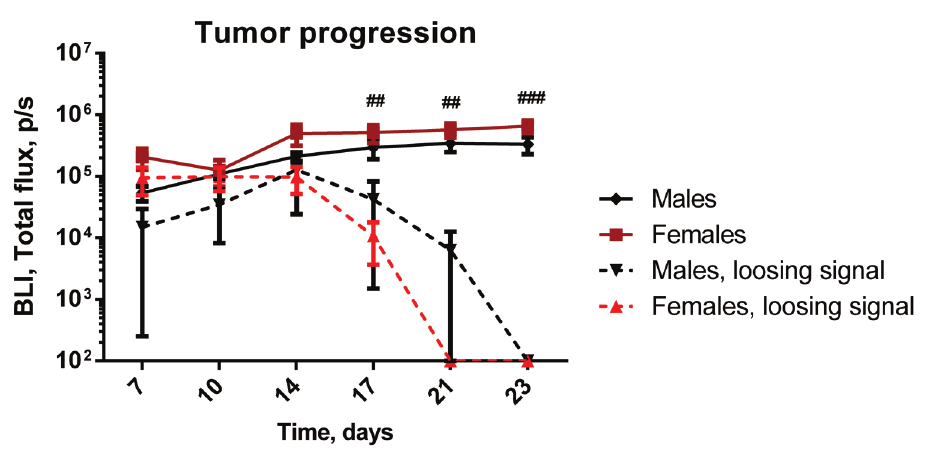
Figure 3. Bioluminescence (BLI) signal reflecting progression of tumor growth. The signal increases in both males and females during the initial 14 days, and reaches a plateau for the remaining of the study. From day 14 an increasing numbers of animals lost the bioluminescence signal. ##/### =females without signal compared to females with